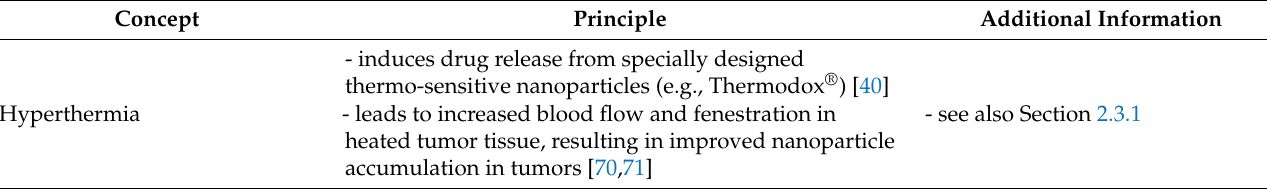
Table 1. Concepts in US-triggered drug